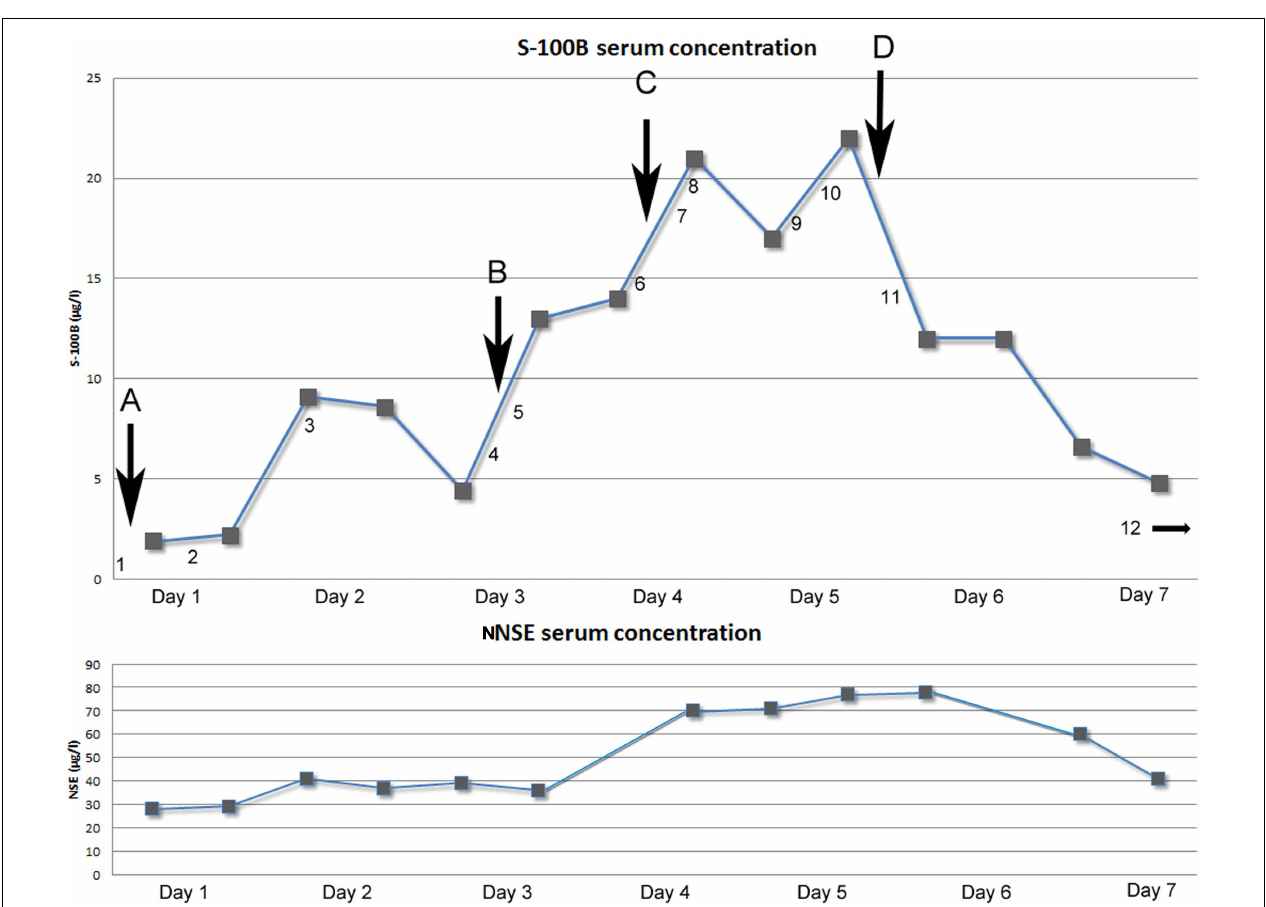
lesions. (7) CT-angiography: no signs of cerebral artery stenosis, dissection, or vasospasm. (8) Midline shift 10mm, unchanged ischemic lesions. (9) CT-Thorax/Upper abdominal: 4.5cm wide tumor in the lung, right upper lobe with growth to the mediastinum. Smaller cancerogenic lumps in the lung parenchyma. Multiple metastasis to the liver. (10) Magnetic resonance imaging (MRI): Midline shift 14mm, compression of the brain stem. Infarctions in right side thalamus, internal capsule, pons, mesencephalon. Cortical infarctions left occipital lobe and right occipital lobe. Cerebellar infarctions ( Figure 3 ). (11) Post-op hemicraniectomy.Thin line of blood beneath synthetic dura.Twelve millimeters midline shift. Unchanged ischemic areas. (12) (On day 8) Midline shift 16mm, epidural hematoma with local mass effect. Brain stem herniation, compressed basal cisternae ( Figure 4 ). Below: Graph showing the temporal profile of serum concentration of NSE ( µ g/l) over time (days).Two data points are missing due to hemolysis contaminating the